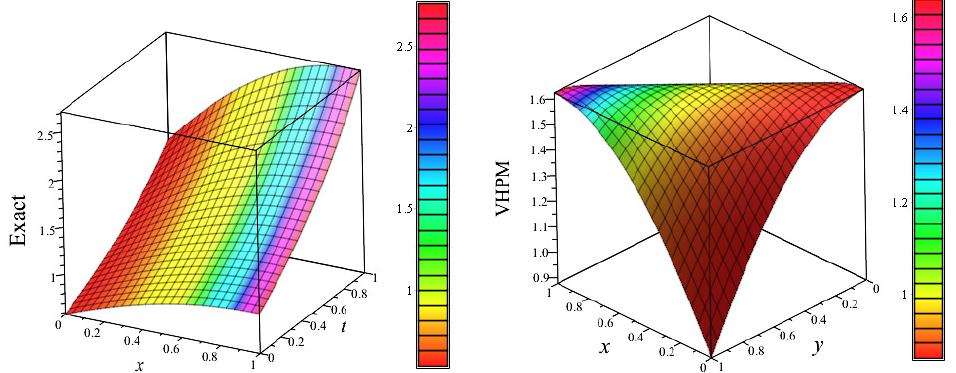
Figure 17. ( Left ) Graphical representation of the exact (as well as the VHPM) solution vs. x ∈ [ 0,1.0 ] vs. t ∈ [ 0,1.0 ] along y = 0.95, and ( Right ) plot of the VHPM solution (with n = 2) (as well as the exact solution) vs. x ∈ [ 0,1.0 ] vs. y ∈ [ 0,1.0 ] at time t =